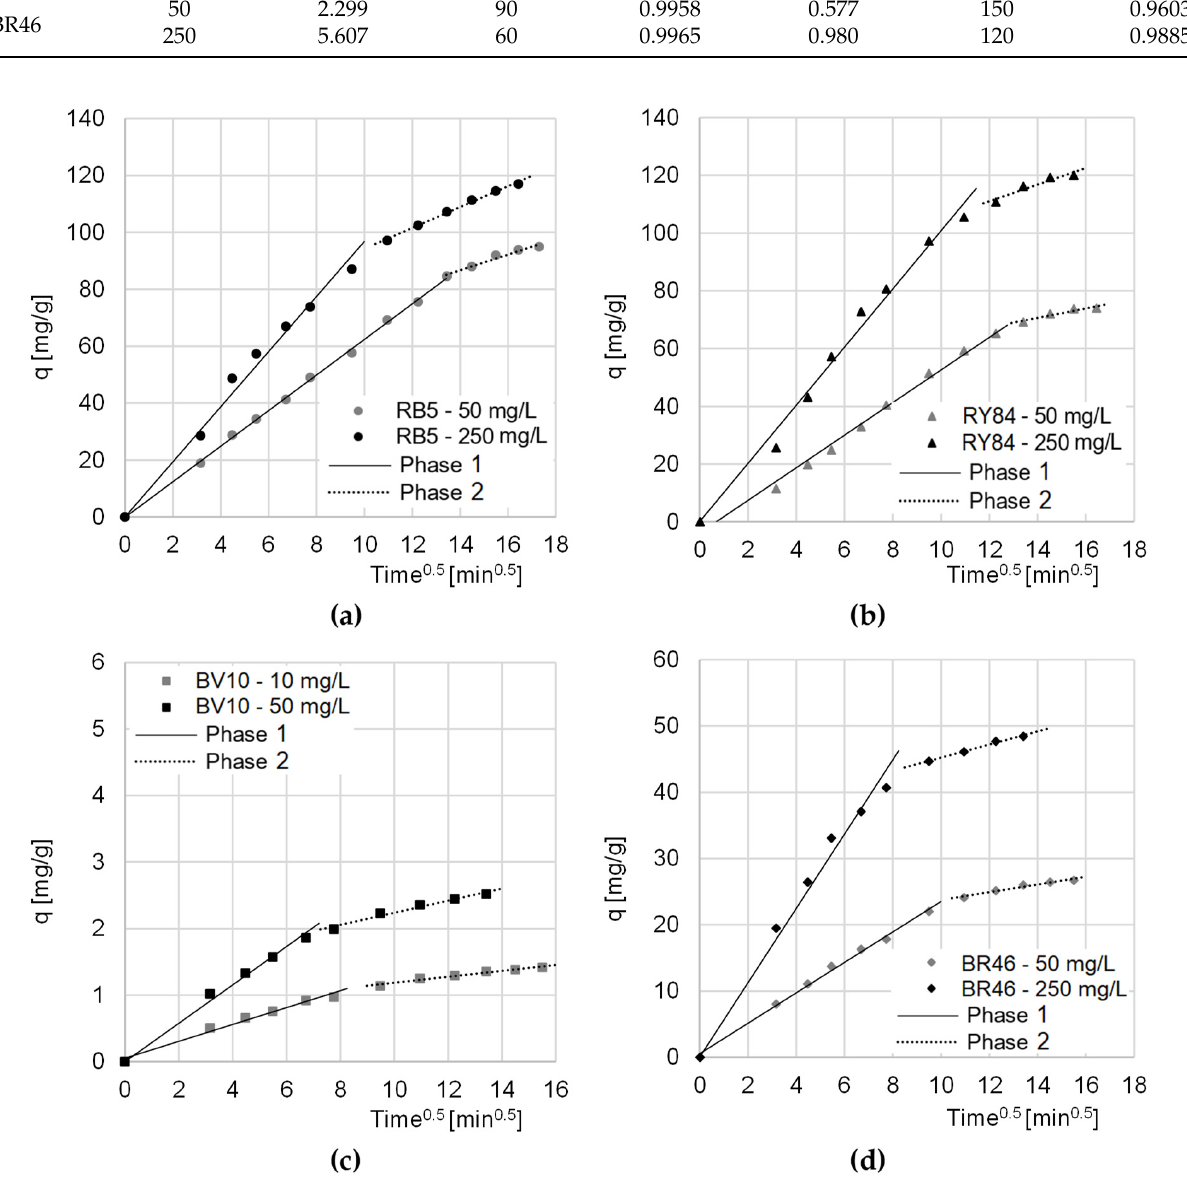
Figure 5. The intramolecular diffusion model of sorption of: ( a ) RB5, ( b ) RY84, ( c ) BV10, and ( d ) BR46 onto CHM. Temp. 22 °C.